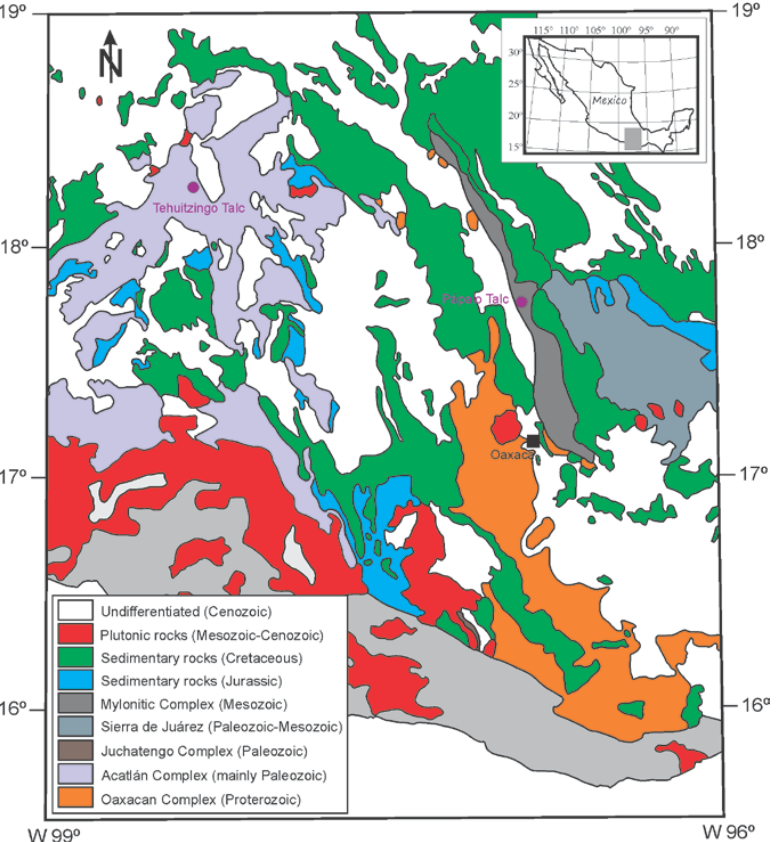
Figure 1. Geological location of the studied talc ore deposits from Mexico . Modified from [16].